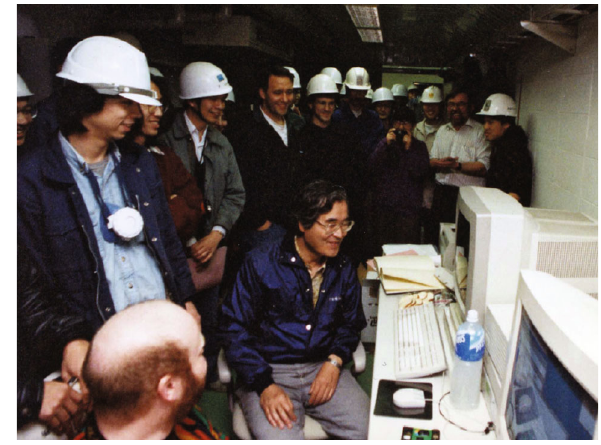
Fig. 2 A photograph taken at 0:00 on April 1st, 1996, the start of the Super-Kamiokande eperiment